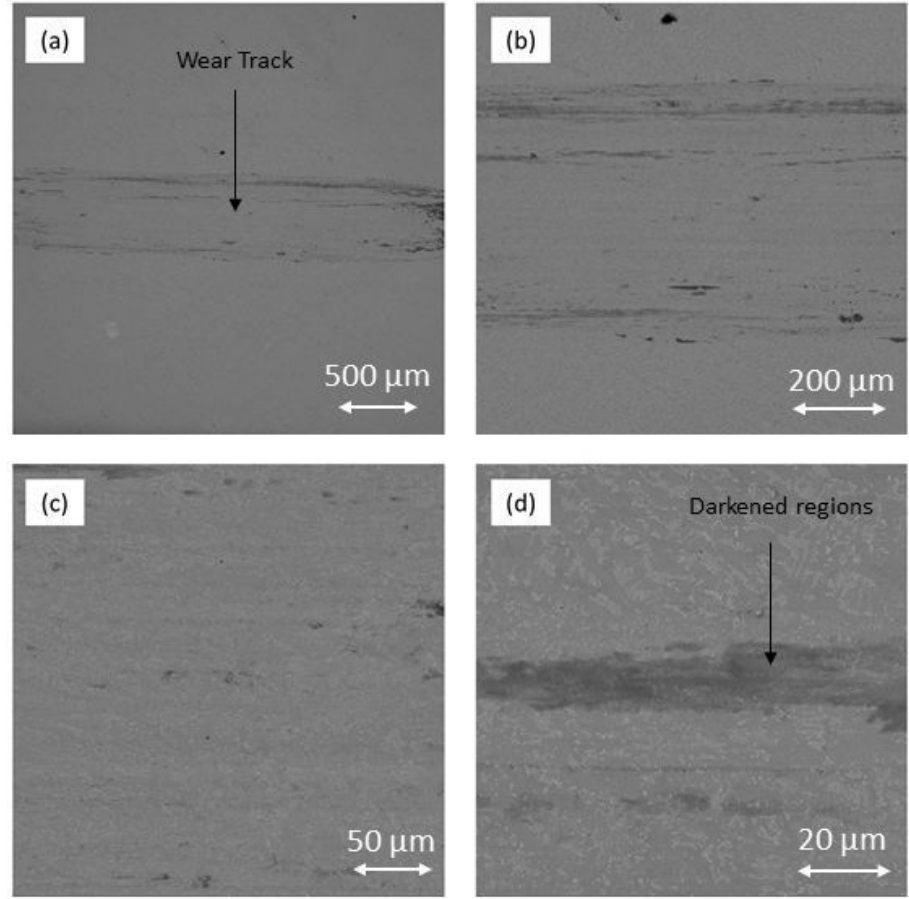
Figure 16. Typical wear tracks of coatings deposited with 4.0 kW on